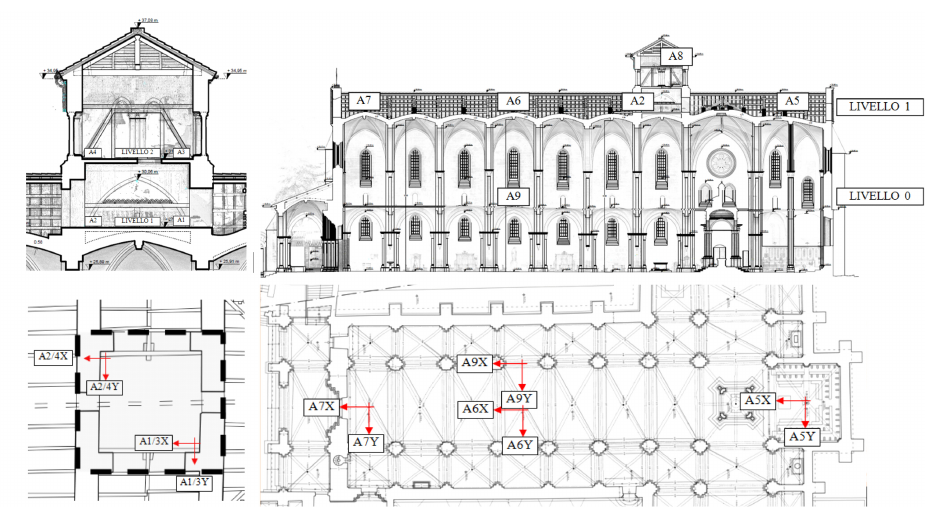
Figure 7. Accelerometers layout: configuration 1 ( left ) and configuration 2 ( right ).